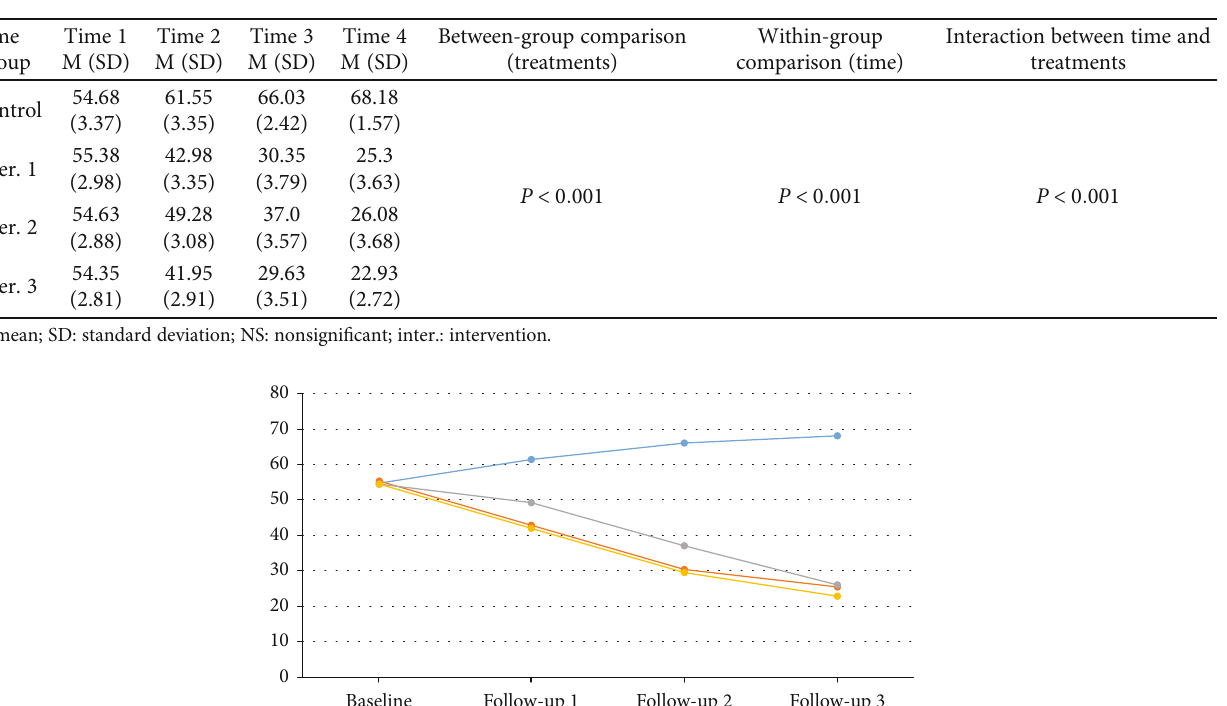
Figure 2: The trend of perceived stress from baseline up to 21-month follow-up. Table 3: Comparisons between trial and control groups in terms of state anxiety at baseline (time 1), 6 months (time 2), 15 months (time 3), and 21 months (time 4) after the intervention.